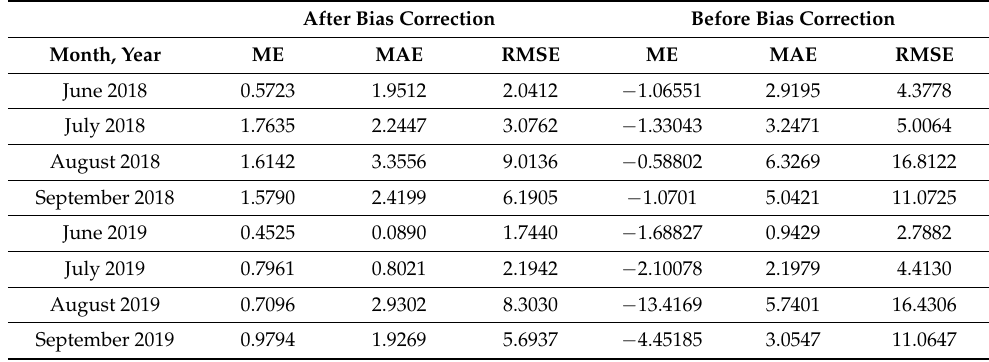
Table 5. The validation of bias correction using statistical test ME, MAE, and